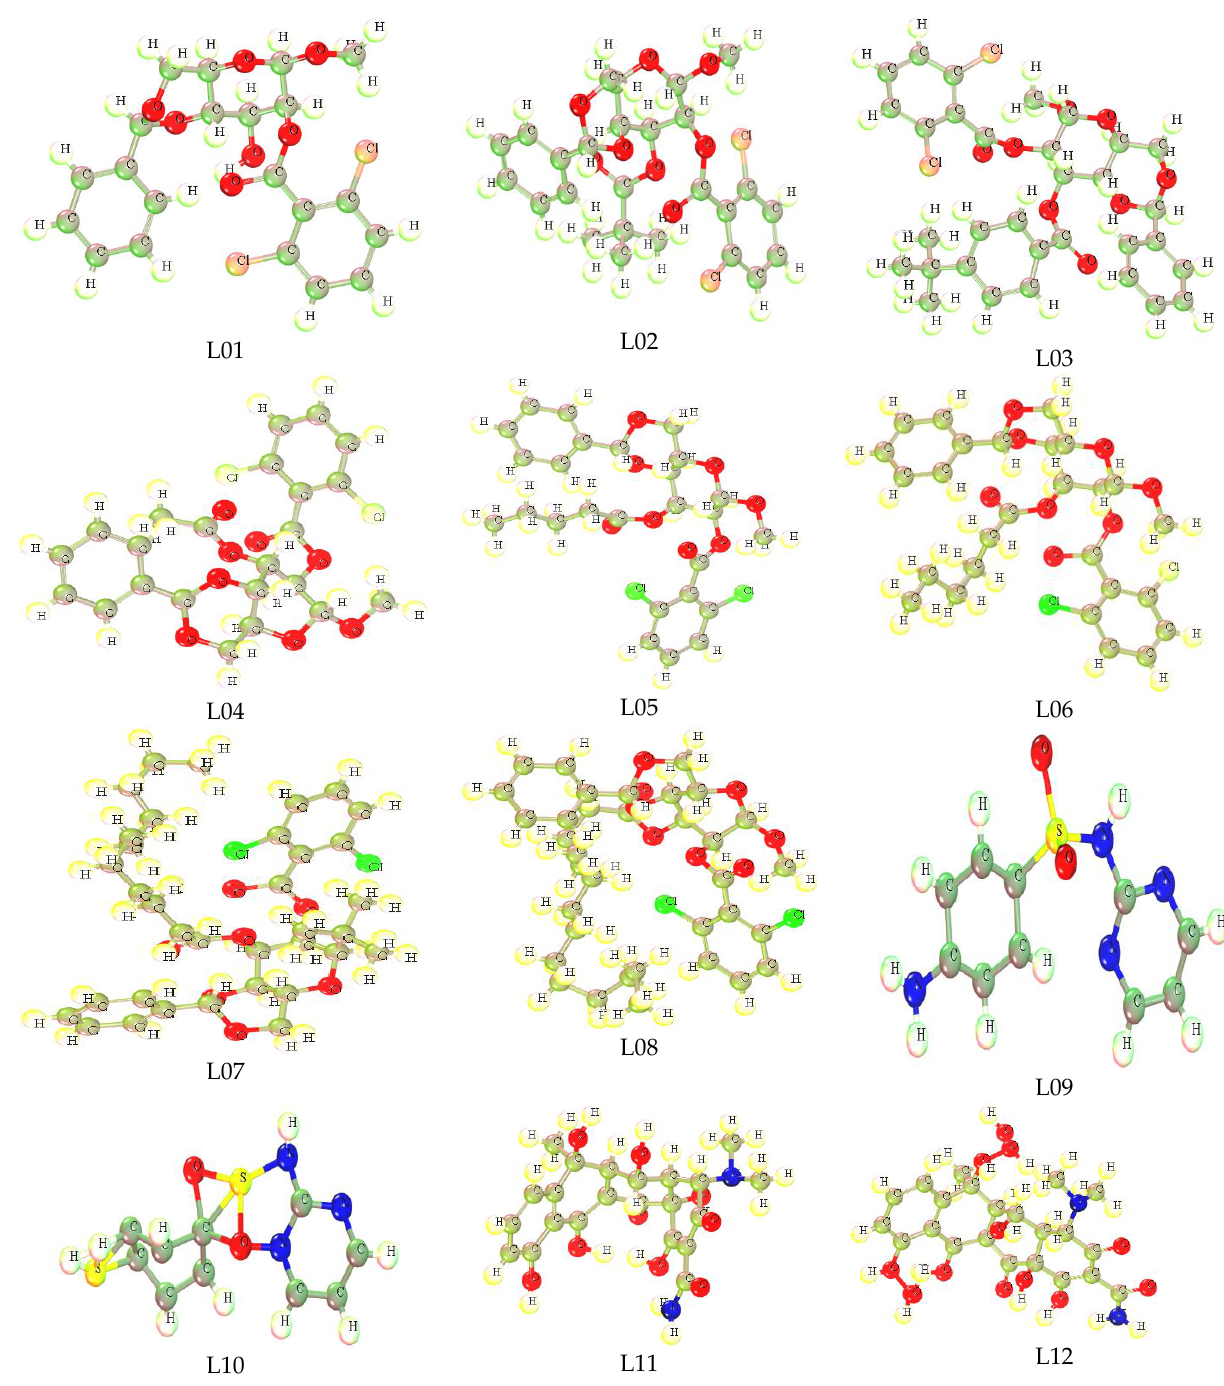
Figure 1. Optimized structure of inhibitors.